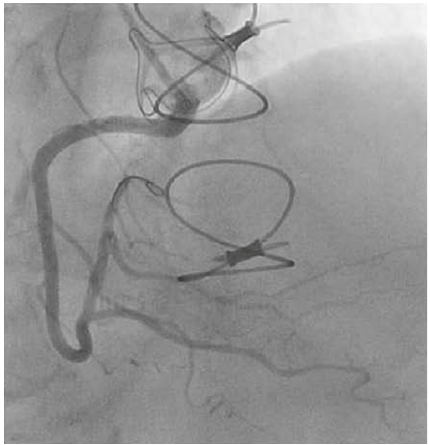
Figure 3: Postprocedure coronary angiogram shows successful revascularization of the right coronary artery with stent